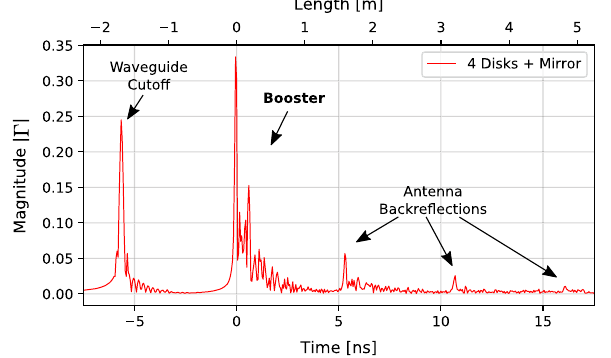
Fig. 7 Group delay including antenna reflection from measurement (red straight line), without antenna reflection in idealized loss-less model(bluedottedline)andafterincludingtheantennareflection(dark- blue dashed line), as well as the corresponding boost factor including the antenna reflection (bold lightlblue line). For the same 4 disk booster as in Fig. 3. We only show a subsection from all recorded